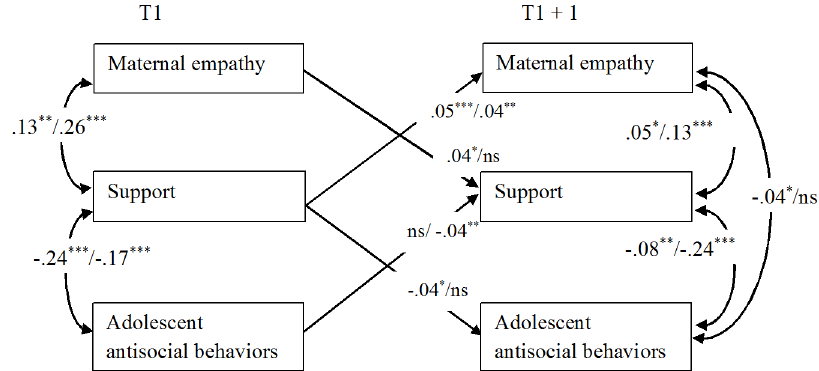
Fig 4. Significant Standardized Results of the Cross-Lagged Models Linking Maternal Empathy, Support, and Adolescent Antisocial Behaviors (A/M Reports). For each cross-lagged effect and correlation, the first result is based on adolescent reports (A) and the second on maternal reports (M). Since the models with time-invariant coefficients were retained as the final ones, we present only two time points (T and T+1), and all coefficients displayed represent the averaged standardized coefficients over the six time intervals. * p < .05, ** p < .01, *** p <